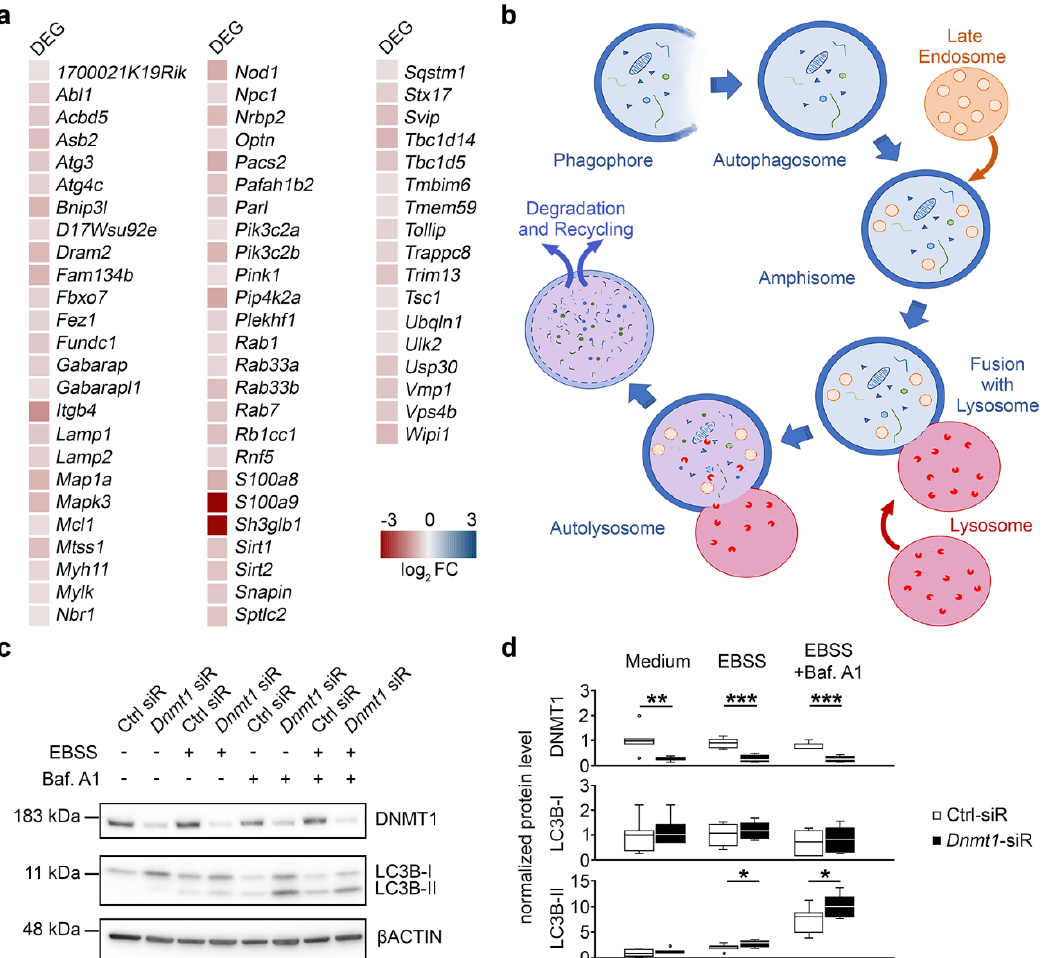
Figure 5. DNMT1 acts on autophagy. ( a ) Heat-map of significantly upregulated genes associated with the GO term autophagy in FAC-sorted cortical interneurons of Pvalb - Cre / tdTomato / Dnmt1 KO mice compared to cells of Pvalb - Cre / tdTomato / Dnmt1 WT mice. Expression level determined by RNA-sequencing (* p < 0.05, Benjamini-adjusted, n = 9 WT and n = 12 KO mice). ( b ) Schematic illustration of the autophagy pathway beginning with the formation of an autophagosome and depicting the transition to an amphisome, which fuses with a lysosome to form the autolysosome, where particles are degraded. ( c ) Protein levels of DNMT1, microtubule-associated protein 1 light chain 3B-I (LC3B-I), and LC3B-II in Ctrl and Dnmt1 siRNA-treated N2a cells in the autophagy assay analyzed by Western blot. Cells were cultured in culture medium or starving solution (Earle’s balanced salt solution (EBSS)) and partly treated with an autophagy inhibitor (bafilomycin A1). ( d ) Quantification of protein levels of the conditions shown in ( c ) normalized to beta-actin (bACTIN) and in relation to the control ( n = 7 experiments; two-tailed Student’s t -test, * p < 0.05, ** p < 0.01, *** p < 0.001). DEG = di ff erentially expressed genes, FC = fold change, bACTIN = beta-actin, Baf. A1 = bafilomycin A1, Ctrl = control, EBSS = Earle’s balanced salt solution, LC3B-I / II = microtubule-associated protein 1 light chain 3B-I / II, N2a = neuroblastoma cells, siR = siRNA.